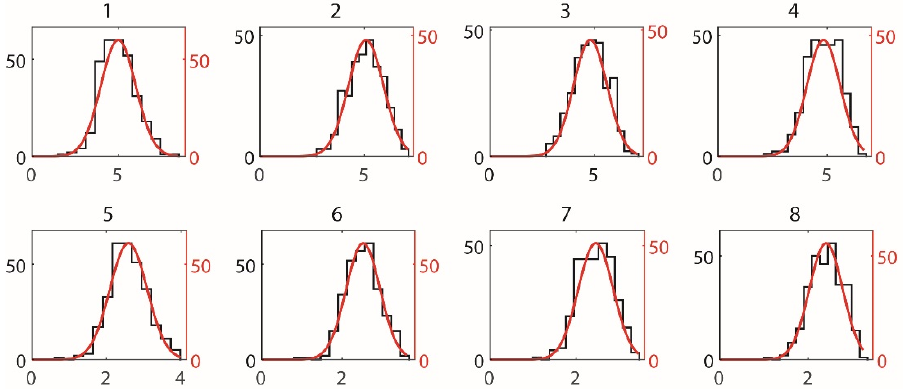
Figure 6. Frequency distribution ( x -axis, number of occurrence) of fill ratio ( y -axis, %) for different combinations of variable levels.